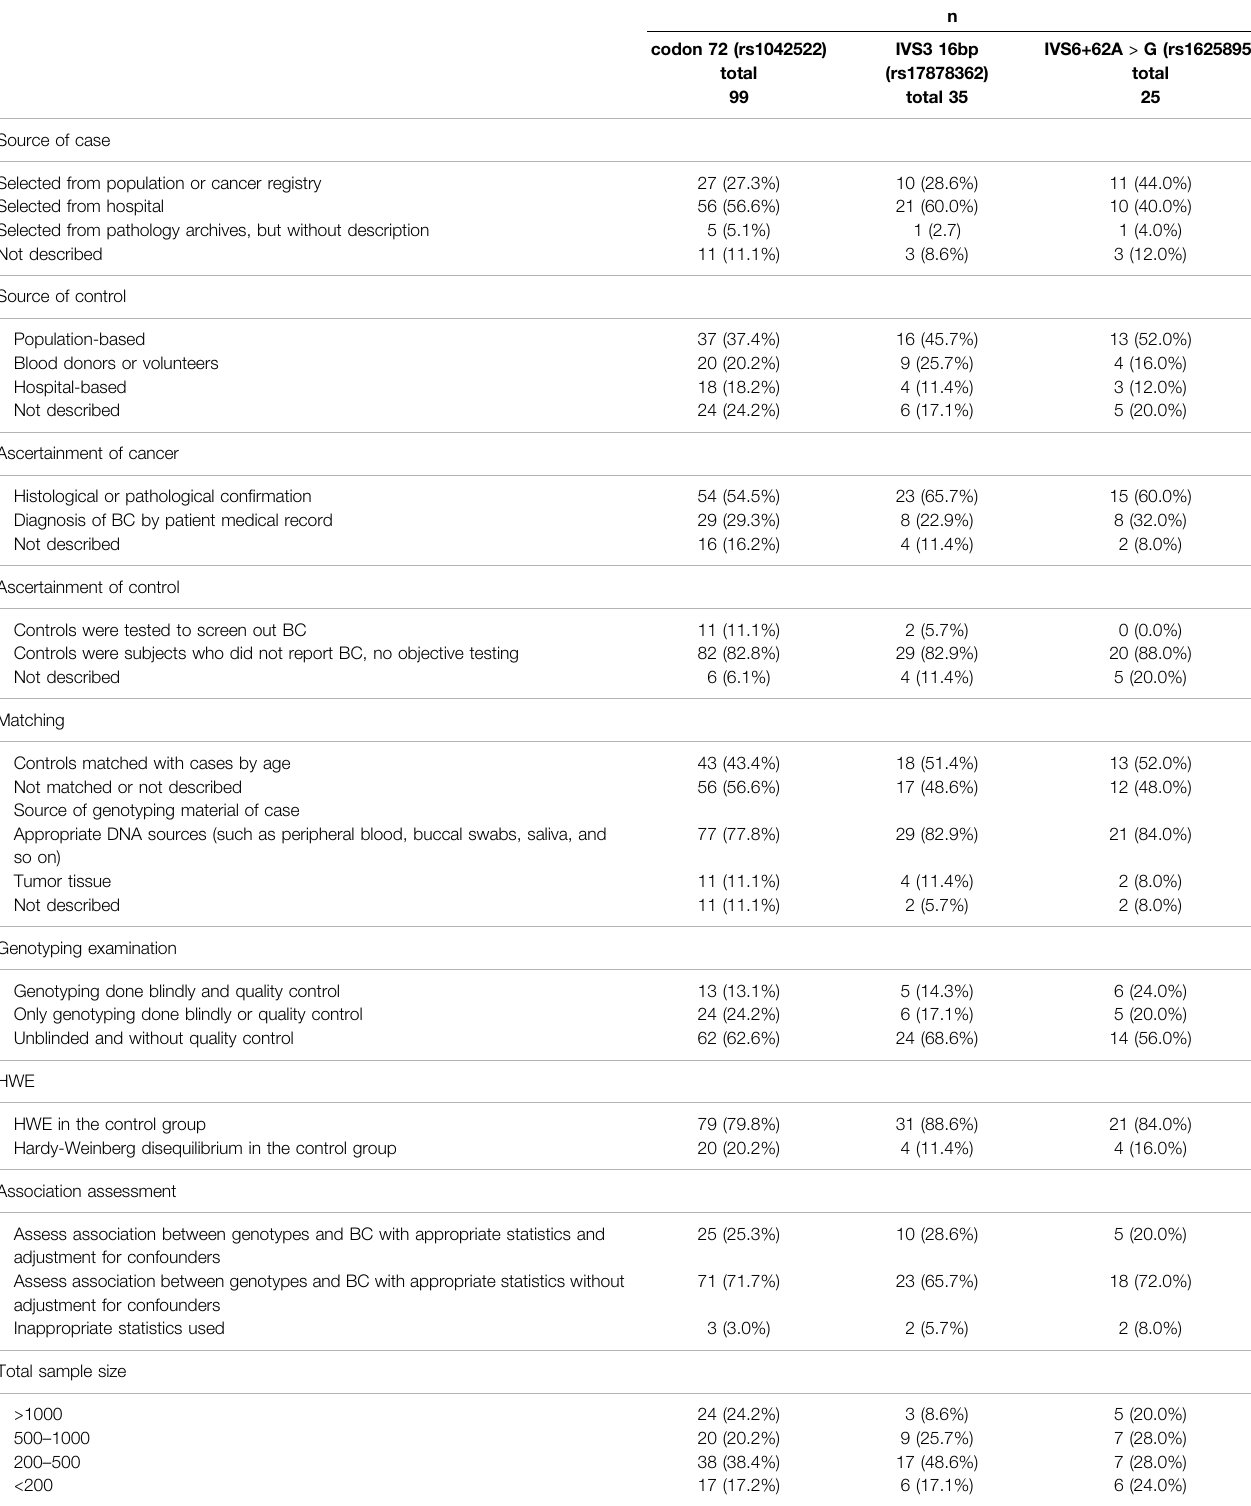
TABLE 1 | Concise characterization of the studies included from 99 articles in present